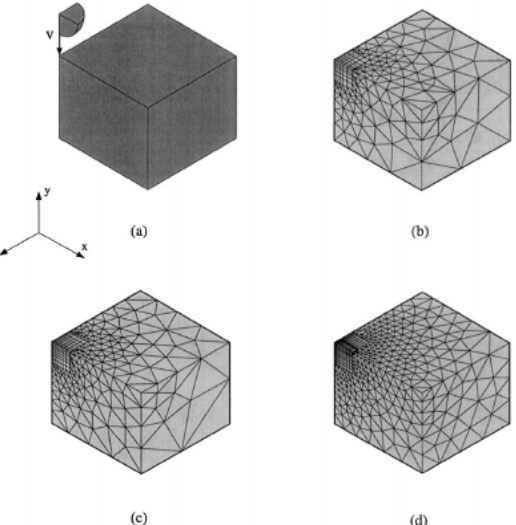
Fig. 4. Geometry and discretized models used in the single-shot model: (a) one-quarter of geometry, and (b-d) three discretized geometries of target with different mesh densities.